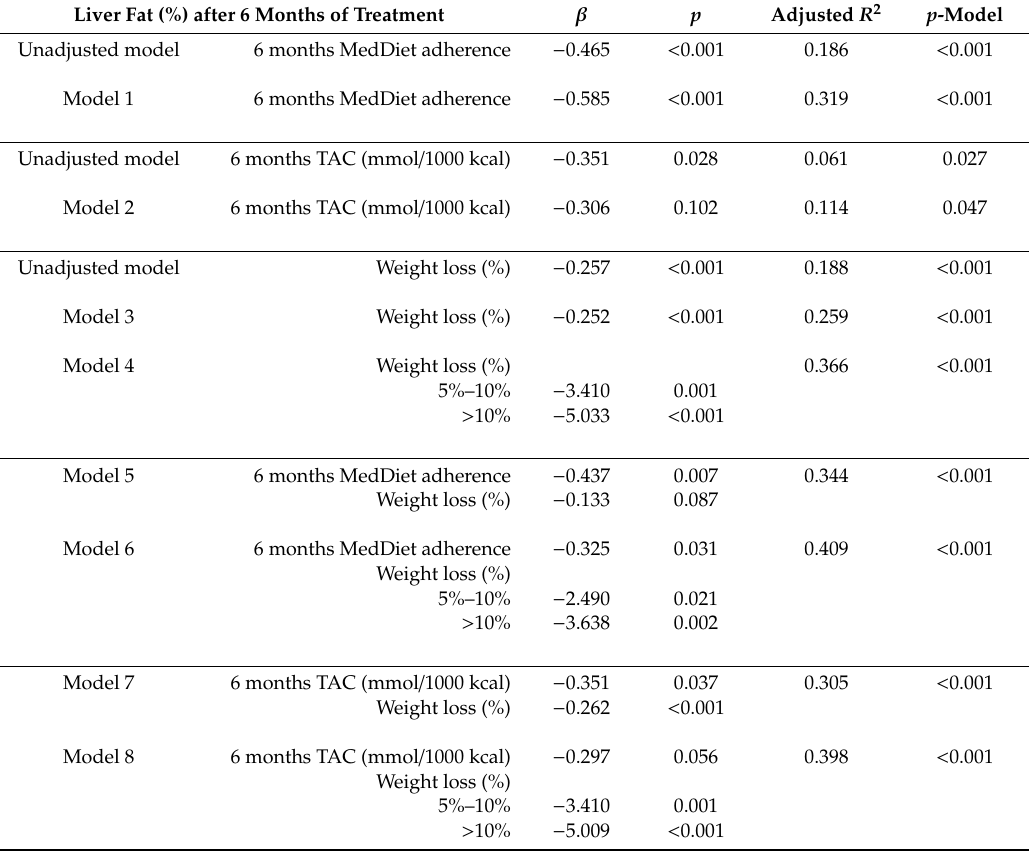
Table 5. Regression analyses of liver fat percentage at 6 months as the dependent variable and MedDiet adherence, total antioxidant capacity, and weight loss percentages after the dietary intervention as independent